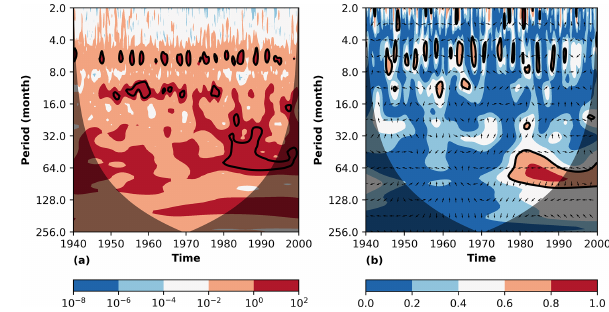
Figure 3. Contours of cross-wavelet transform (a) and wavelet co- herence (b) between ENSO and rainfall in the ORB from 1940 to